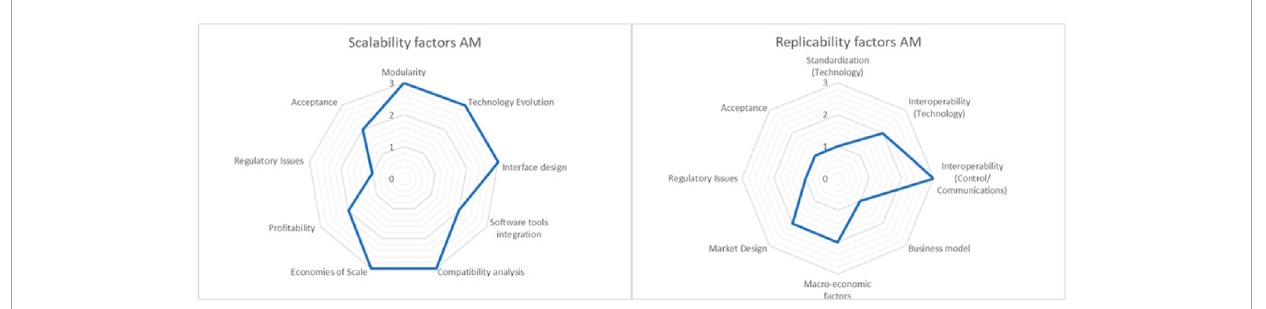
factor, acceptance of the solution is not included in the study. By rating the several factors, the overall graphs are formed, as depicted in Figure 10